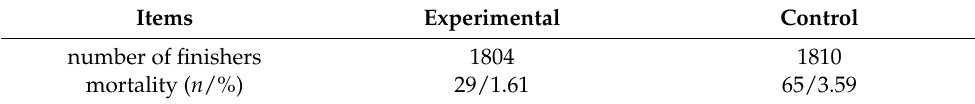
Table 2. Mortality of pigs.